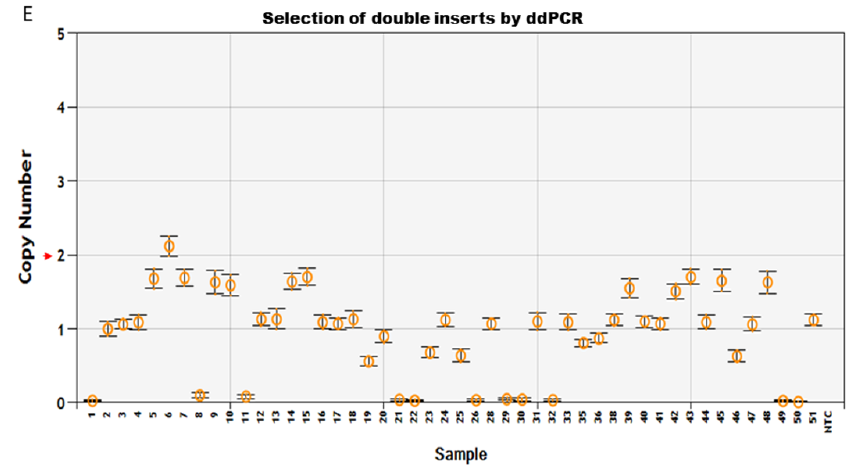
Figure 2. Transgenic components were removed in the final product of Arabidopsis thaliana (L.) Heyhn. transformed by pHHCGR − Hsp18.2 /pHHCGS − Hsp18.2 vector. ( A ) Screening for T1 lines carrying single copy insert (SCI) of pHHCGR − Hsp18.2 or pHHCGS − Hsp18.2 by ddPCR. ( B ) In trans- genic T1 lines with SCI, the presence or absence of PCR products of Cas9p (1082 bp), Bar (422 bp), and eGFP (749 bp) showed distinct results in the same plant before and after editing. ( C ) In trans- genic T1 lines with SCI, confocal images showed distinct results of eGFP expression in the same plant before and after editing. Bright, bright-field microscopy; PI, propidium iodide, fluorescent dye staining nuclei due to intercalating binding with DNA, excitation wavelength (535 nm) and emis- sion wavelength (617 nm) on confocal microscope; eGFP, eGFP protein mainly accumulated in the nuclear region due to an SV40 NLS added before the eGFP coding region, excitation wavelength (488 nm) and emission wavelength (509 nm) on the confocal microscope. Scale bar, 15 µm. ( D ) Se- quencing results of PCR products showing the junction sequence after editing and repair via non- homologous end-joining (NHEJ). BE/AE, before/after editing; TR, truncated region; |, cutting site. Three-base PAM sequence highlighted in green, mismatched bases indicated with red font color. ( E ) Selection for T2 lines carrying double inserts of the target gene by ddPCR.